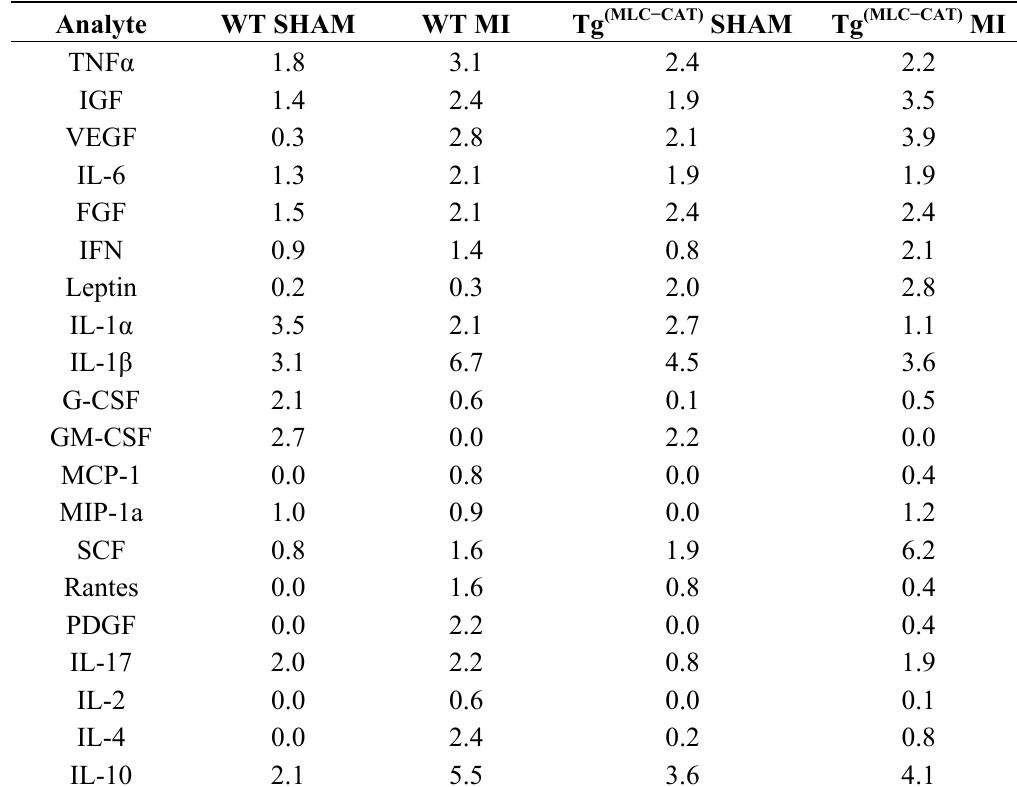
Table 1. Levels of cytokines determined by array. Values are OD450/µg